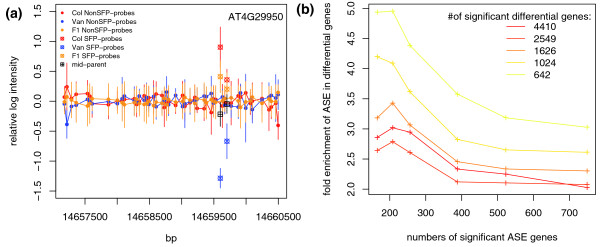
Detection of ASE in F1 hybrids. (a) Col ASE for gene AT4G29950. After correction of overall gene expression level, the relative log intensity (y-axis) for Col (red), Van (blue), F1 hybrids (orange), and mid-parent (black) were plotted along chromosomal positions (x-axis), with standard deviation indicated. Solid dots, non-SFP probes; crossed circles, SFP probes. (b) Fold enrichments of significant ASE genes within the differential genes between Col and Van. The numbers of significant calls were selected according to permutation-based FDRs.